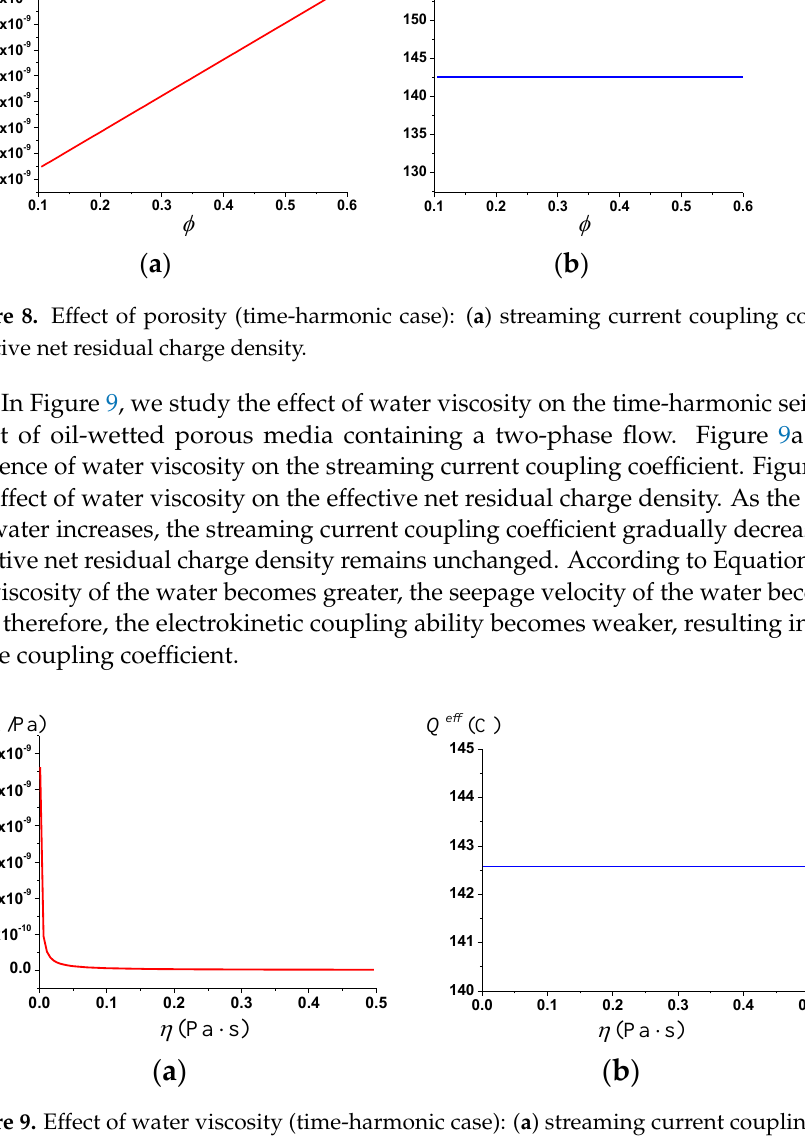
Figure 7. Effect of pore size (time-harmonic case): ( a ) streaming current coupling coefficient; ( b ) effective net residual charge density.